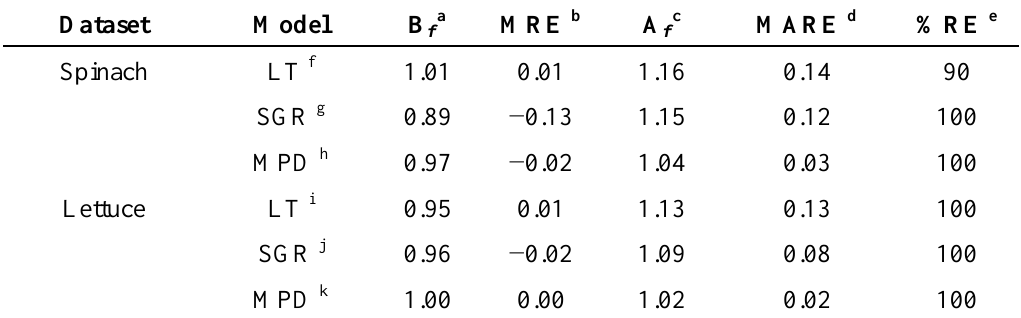
Table 2. Performance of secondary growth models for a mixture of E. coli O157:H7 NT in blanched spinach and fresh-cut iceberg lettuce for